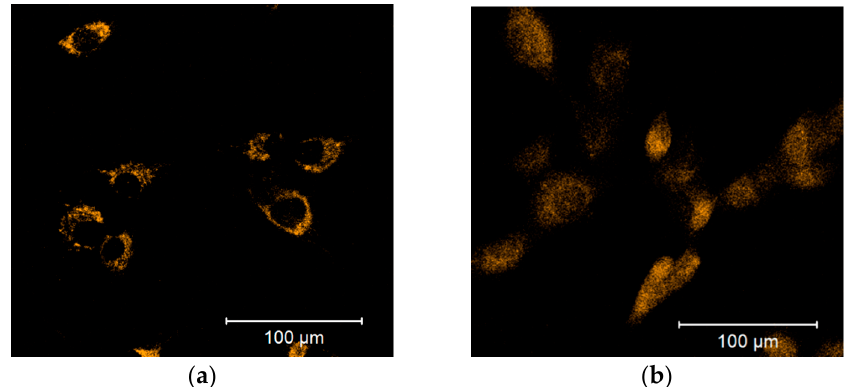
Figure 3. Release of the mitochondrial ROS-sensitive CM-H2XRos fluorescent probe to the cyto- plasm is induced by a 100 µM diphenyleneiodonium chloride (DPI) treatment of MG-63 cells. ( a ) Control group treated with 0.5% vol. DMSO. ( b ) Group exposed to a 100 µM DPI concentration. The images were taken with a Zeiss LSM 510 microscope, 10× objective, 5 µM CM-H2XRos probe concentration.